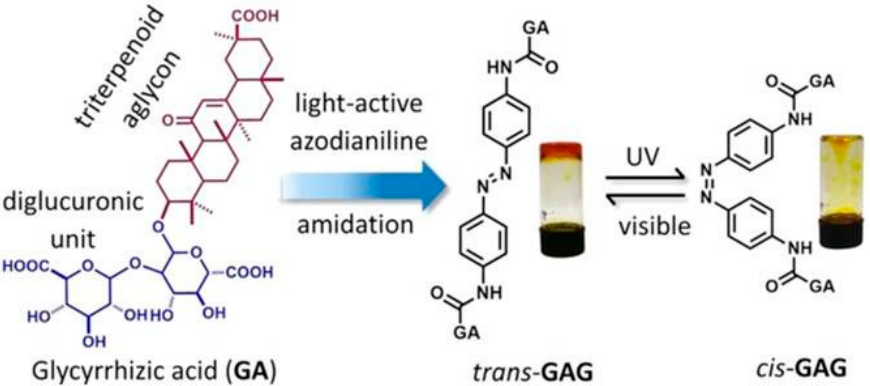
Figure 7. Schematic representation of the gelation of trans-GAG and its reversible trans–cis isom- erization. Reprinted with permission from Copyright (2018) Wiley-VCH GmbH. ization. Reprinted with permission from Copyright (2018) Wiley-VCH